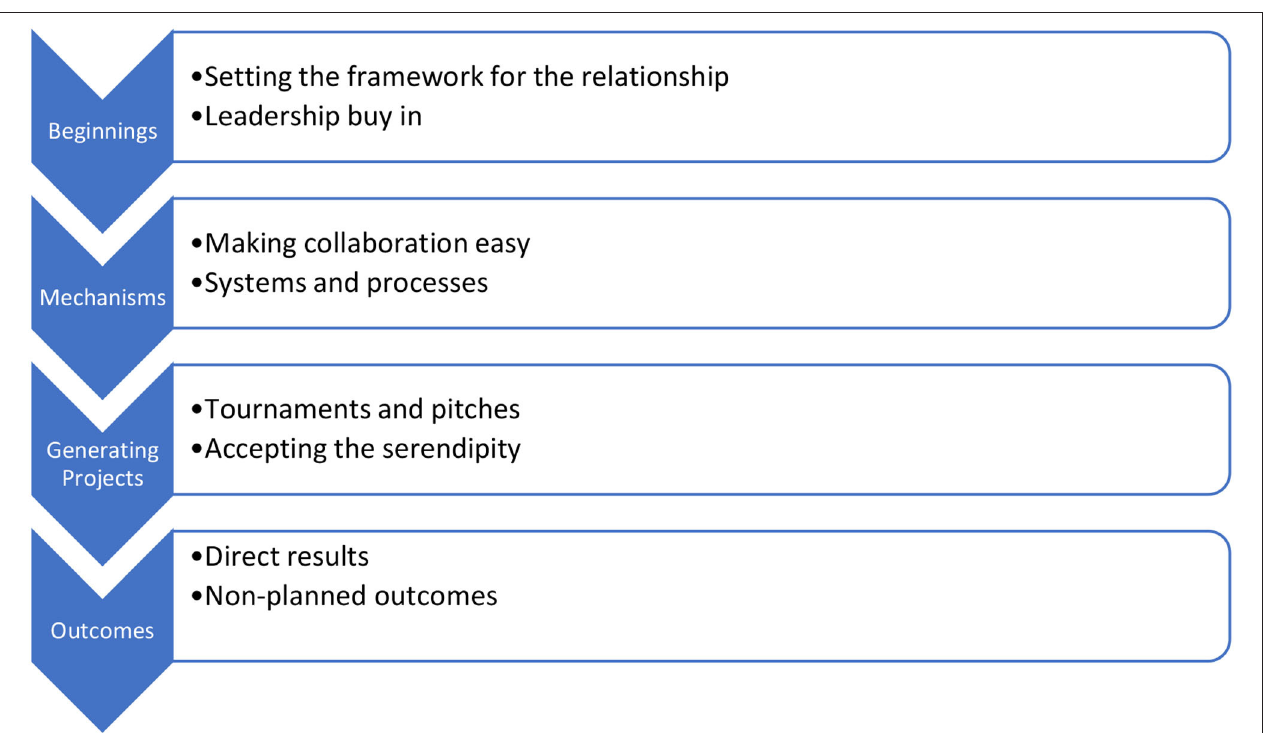
FIGURE 1 | Steps in the University Community relationship